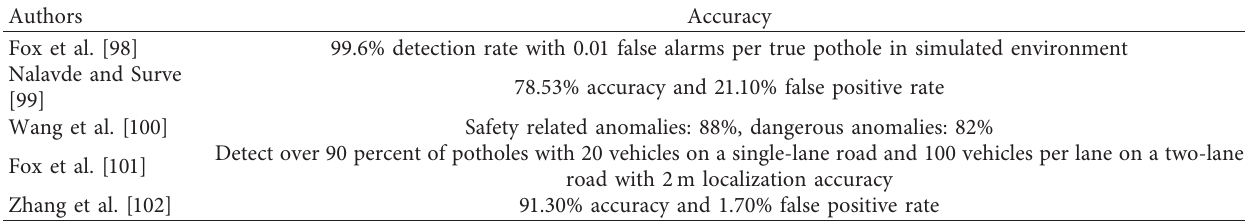
Table 3: Research studies using SVM as the main method.